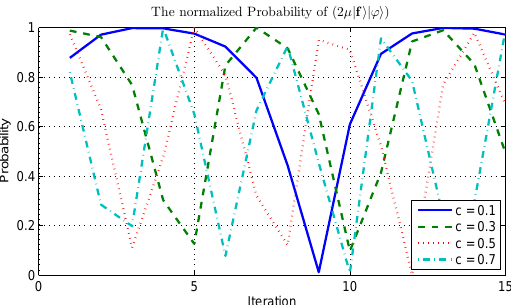
Figure 3: The normalized probability of (2 µ | f (cid:105) | ϕ (cid:105) ) through the iterations for di ff erent values of